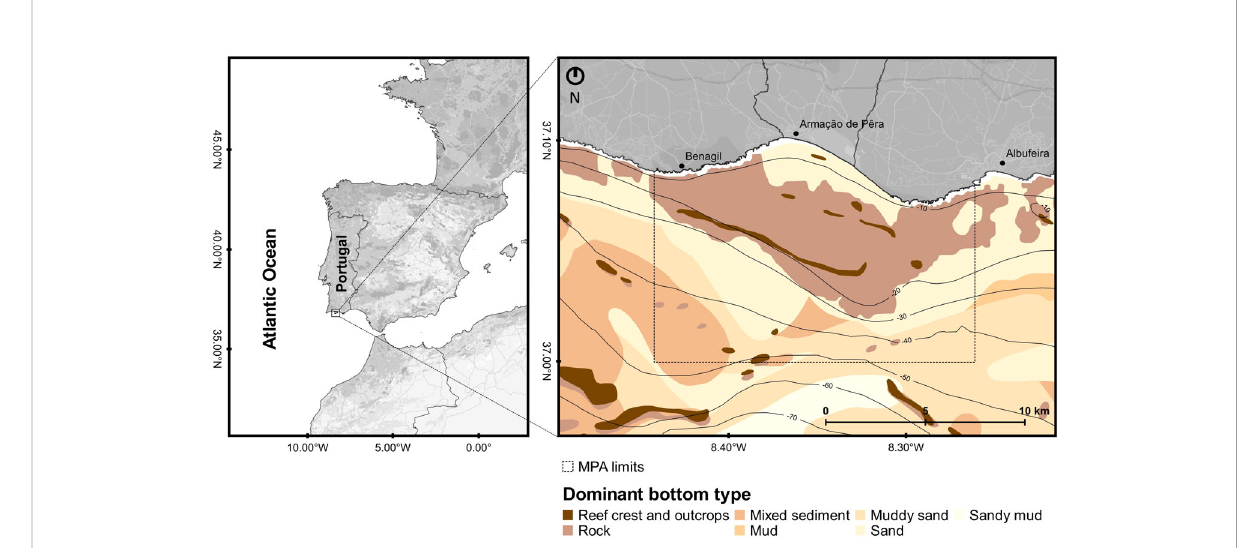
FIGURE 1 Map of the study area with dominant bottom types. Data based on “ Broad-scale seabed substrate map of the European sea areas: EUSeaMap ” (EMODnet Seabed habitats- https://www.emodnet-seabedhabitats.eu). The dotted line shows the proposed MPA area